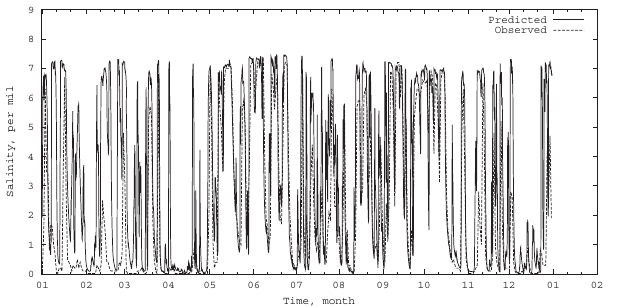
Fig. 2. Time-series of observed and modelled surface salinity in the Figure 2: Time-series of observed and modelled surface salinity in the Klaip ė da harbour. 2 Klaip˙eda harbour.